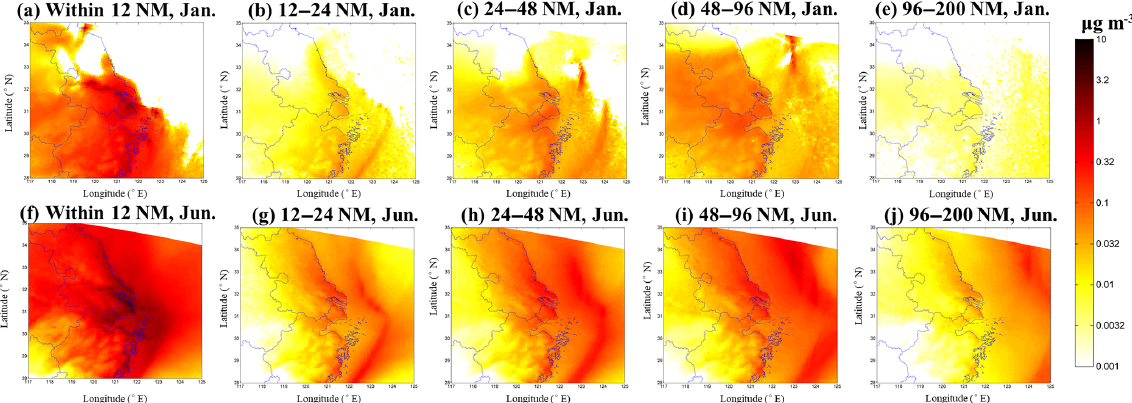
Figure 4. Contributions to PM 2 . 5 concentrations from shipping emissions at distances within 12NM of shore (including inland-waters) (a, f) , 12 to 24NM from shore (b, g) , 24 to 48NM from shore (c, h) , 48 to 96NM from shore (d, i) and 96 to 200NM from shore in